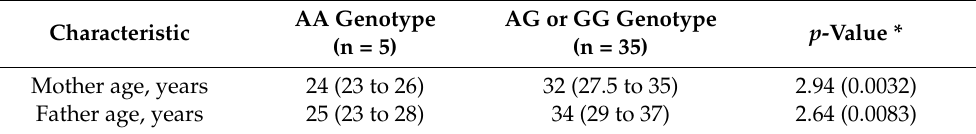
Table 2. Genetic protective IGF2 profile in the IUGR group.